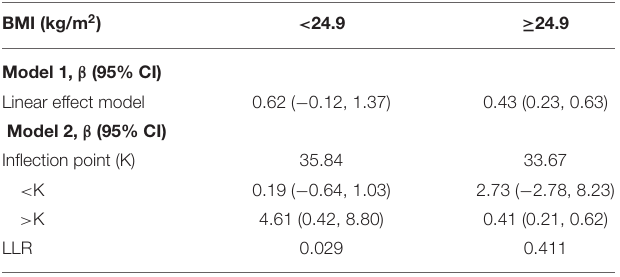
TABLE 5 | Threshold effect analysis of METS-IR and serum ferritin (ng/ml) stratified by BMI (kg/m 2 ). BMI (kg/m 2